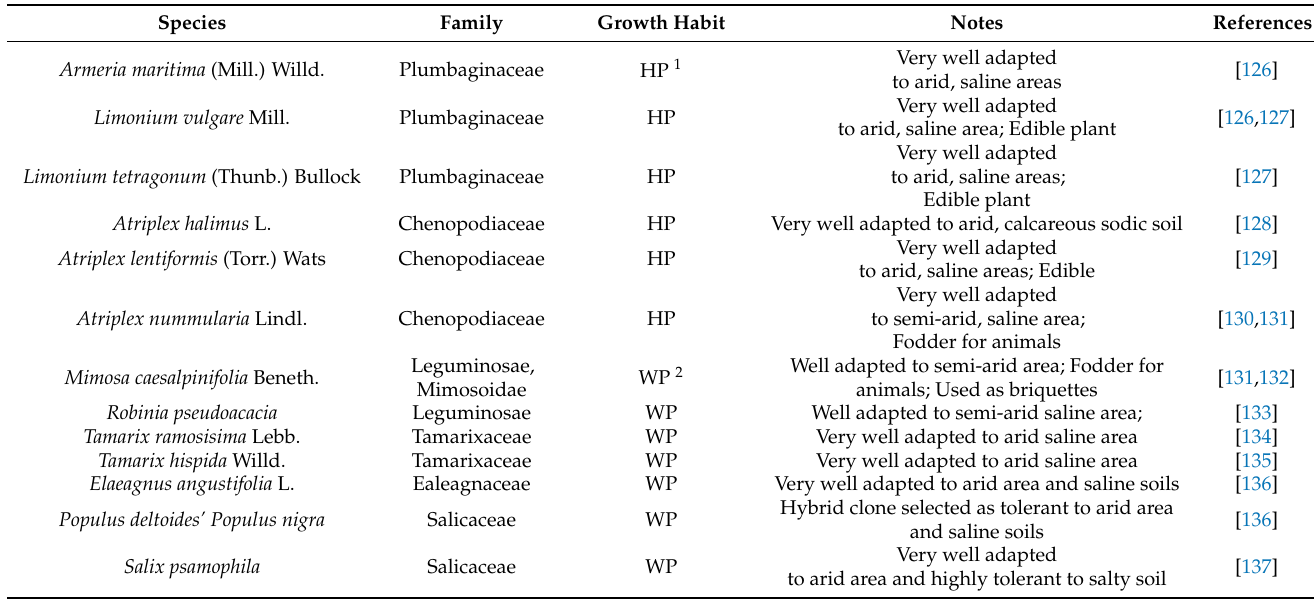
Table 1. Examples of herbaceous and woody plants suitable for growth in arid areas on saline marginal land under agricultural